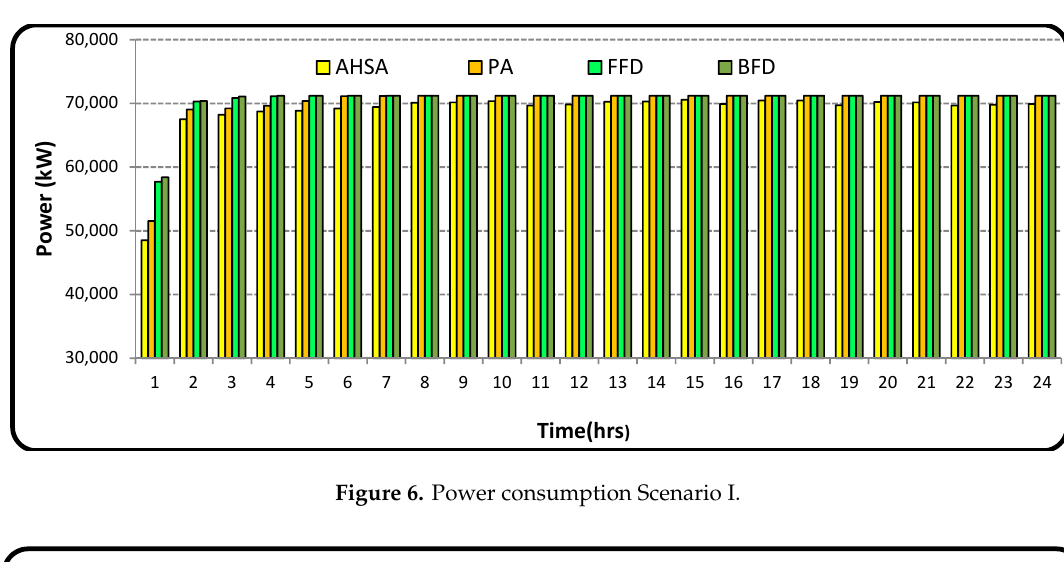
Appl. Sci. 2020 , 10 , 2323